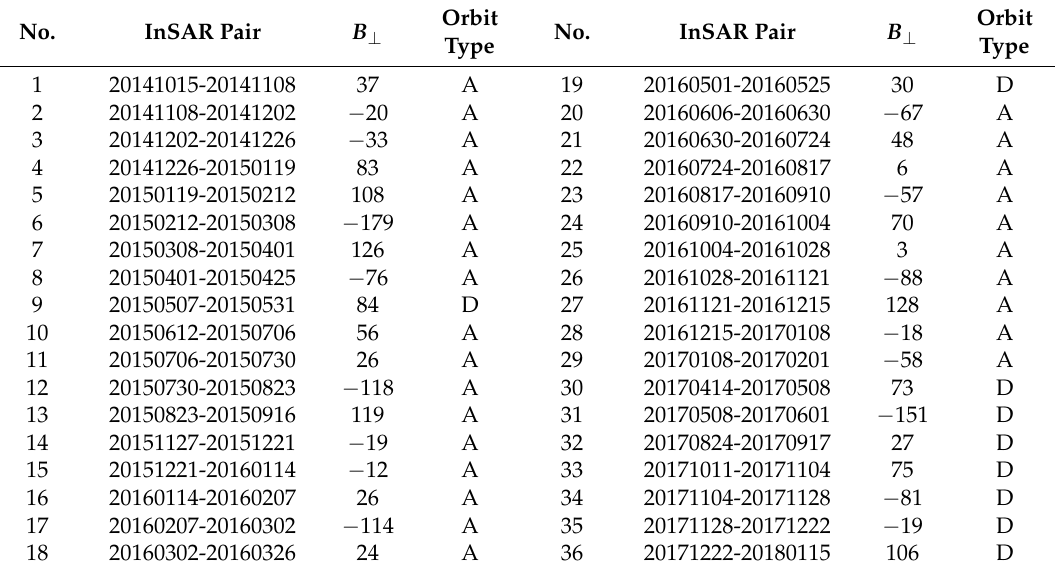
Table 2. The information of 36 InSAR pairs formed using the 45 Sentinel-1A SAR images.